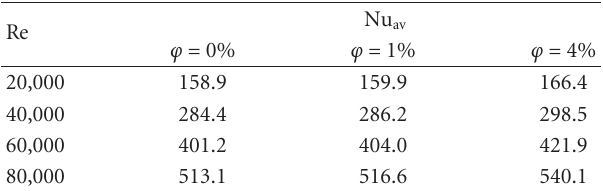
Figure 8: Average heat transfer coe ffi cient for all concentrations and Re. Table 6: Average